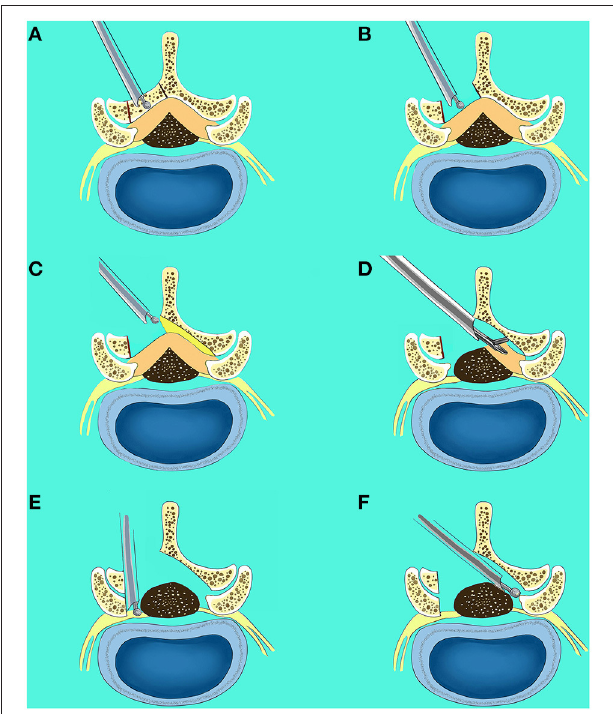
FIGURE 1 | Surgical procedures of lumbar endoscopic unilateral laminotomy bilateral decompression (LE-ULBD). (A,B) The inferior edge of the cranial lamina and the base of the spinous process of the ipsilateral side were removed by the endoscopic burr; (C) undercutting of the contralateral cranial lamina was performed; (D) the ipsilateral and contralateral ligamentum flavum was identified and removed piecemeal with endoscopic punches and forceps; (E) the ipsilateral medial facetectomy was performed to decompress the lateral recess and ensure adequate decompression of the traversing nerve root; (F) the contralateral medial facetectomy was performed to decompress the lateral recess and ensure adequate decompression of the traversing nerve root.